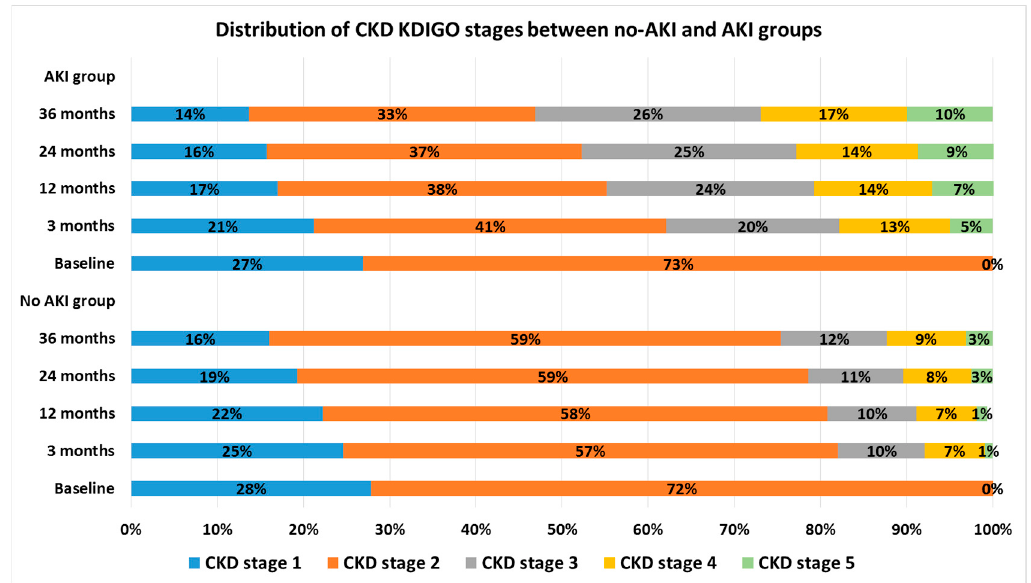
Figure 5. Comparison of the distribution of the Kidney Disease: Improving Global Outcomes chronic kidney disease (KDIGO CKD) stages during the follow-up period of 36 months between the patients with and without AKI after radical